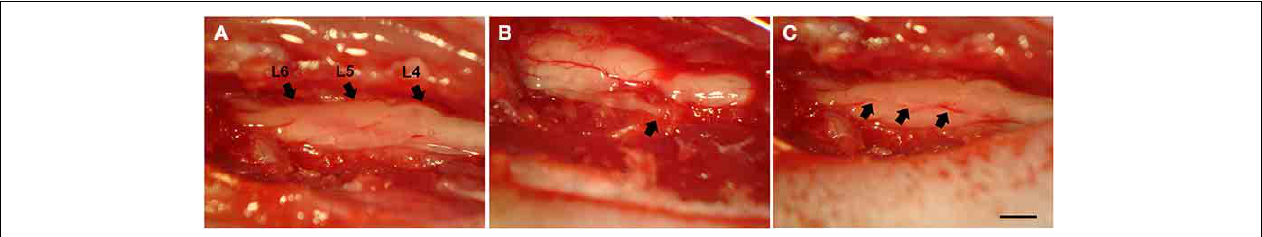
FIGURE 1 | Dorsal view of the lumbar spinal cord at L4-L6 level, following hemi-laminectomy. (A) Lumbar intumescence showing intact L4–L6 dorsal roots. (B) Animal without reimplantation. The arrow shows one